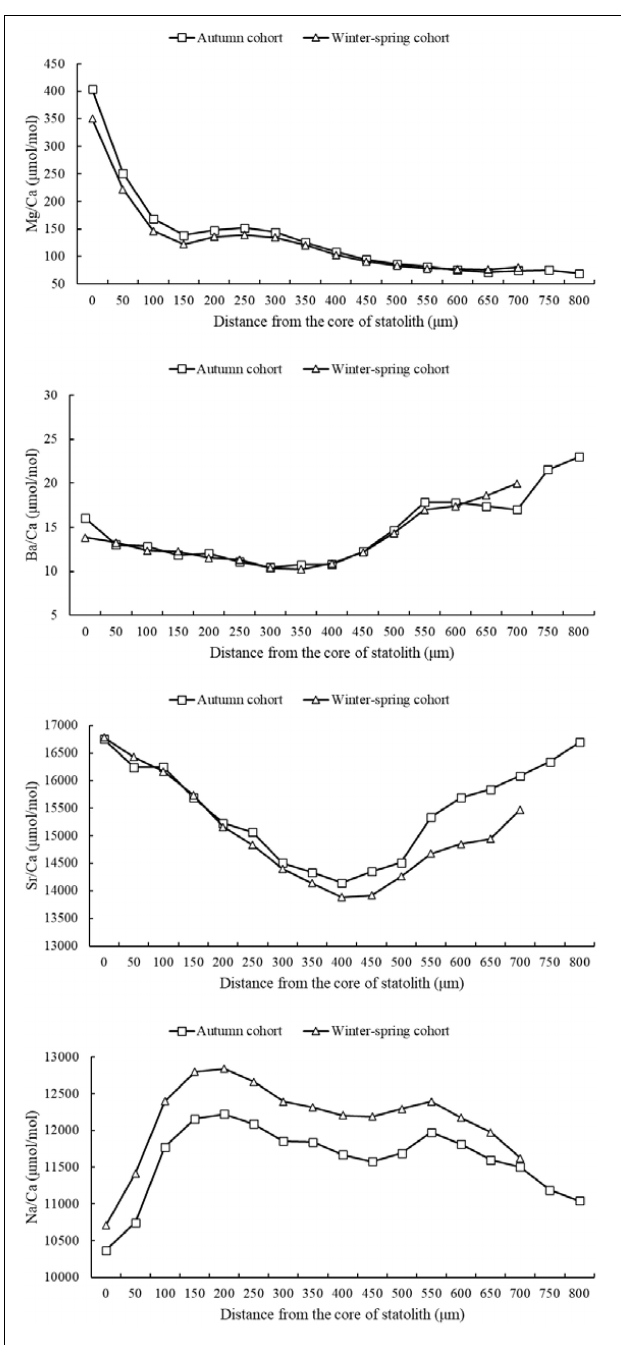
FIGURE 4 | Ratios ( µ mol/mol) of trace elements to Ca in statolith of winter-spring and autumn cohorts of Ommastrephes bartramii from core to rostrum